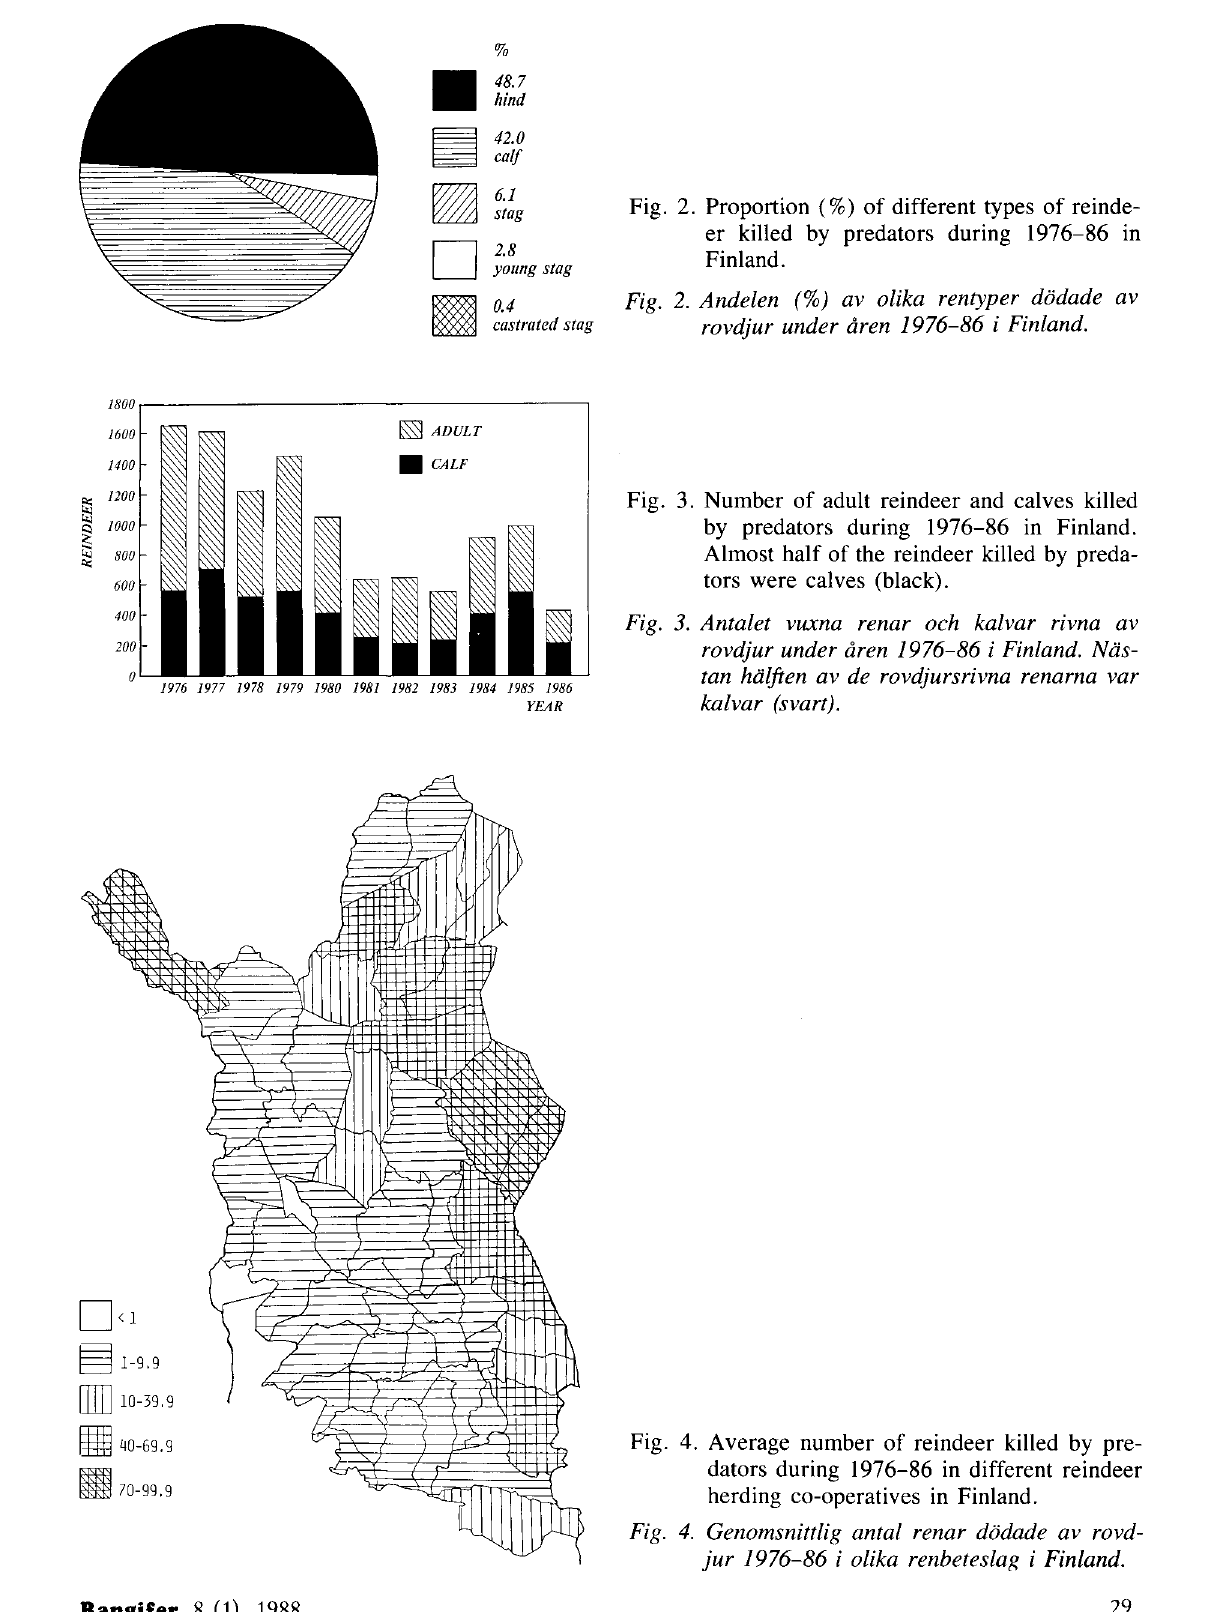
Fig. 4. Average number of reindeer killed by pre dators during 1976-86 in different reindeer herding co-operatives in Finland. Fig. 4. Genomsnittlig antal renar dodade av rovd jur 1976-86 i olika renbeteslag i